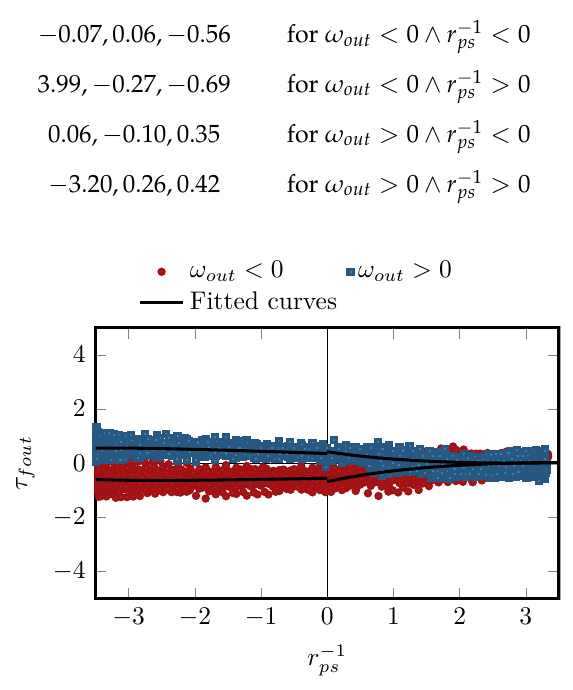
Figure 15. Coulomb friction, measurements and fitted